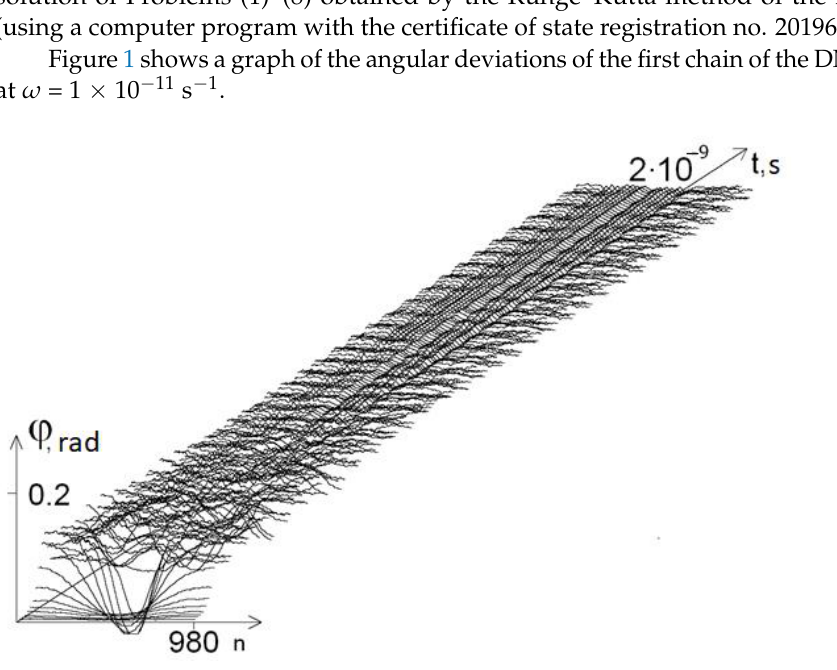
Figure 1. Graph of the angular deviations of the first chain of the gene encoding interferon alpha 17 at ω = 1 × 10 −11 s −1 .